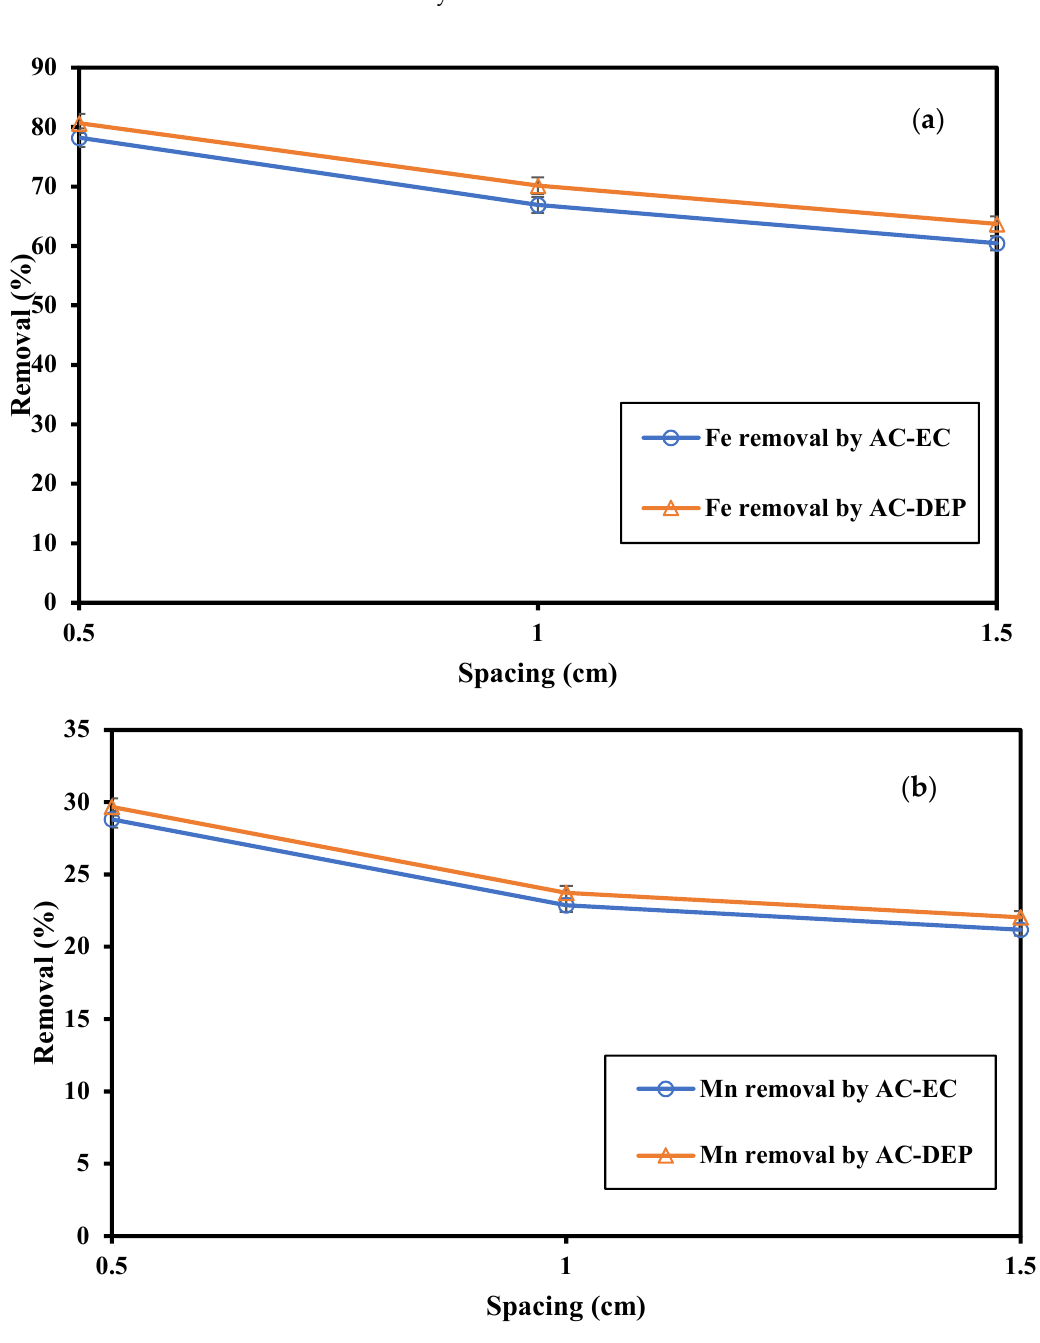
Figure 7. The removal percentage of Fe and Mn using variable electrode spacing, electrolysis time of 30 min and applied current 600 mA. ( a ) Fe removal percentage; ( b ) Mn removal percentage.